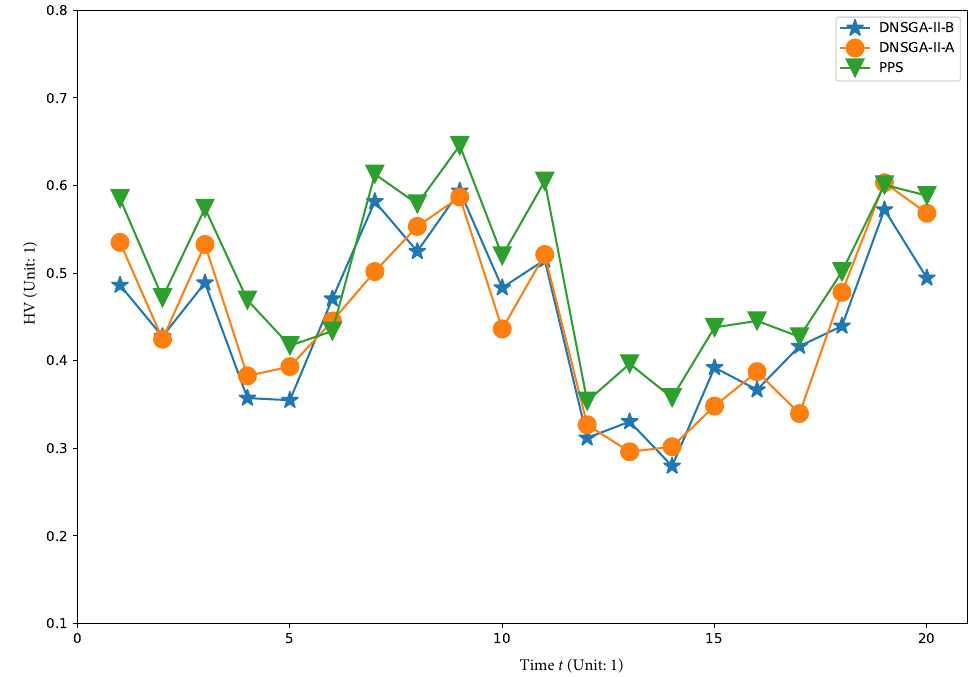
Figure 8. Obtained HV of three algorithms with τ t =